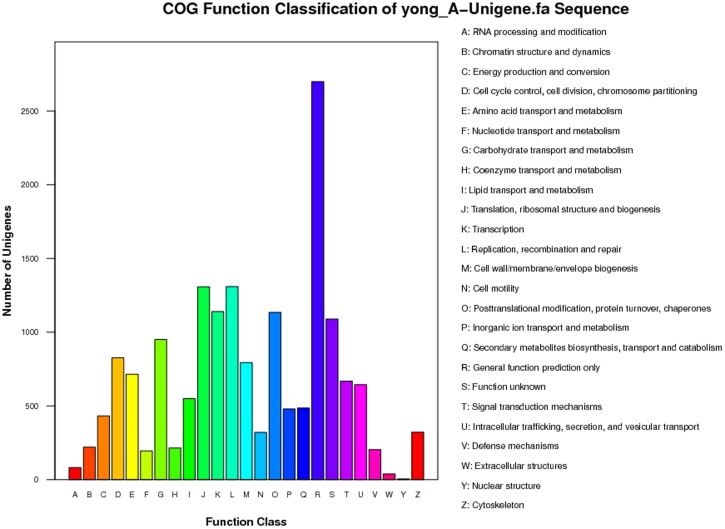
Histogram presentation of clusters of orthologous groups’ (COG) classifications.